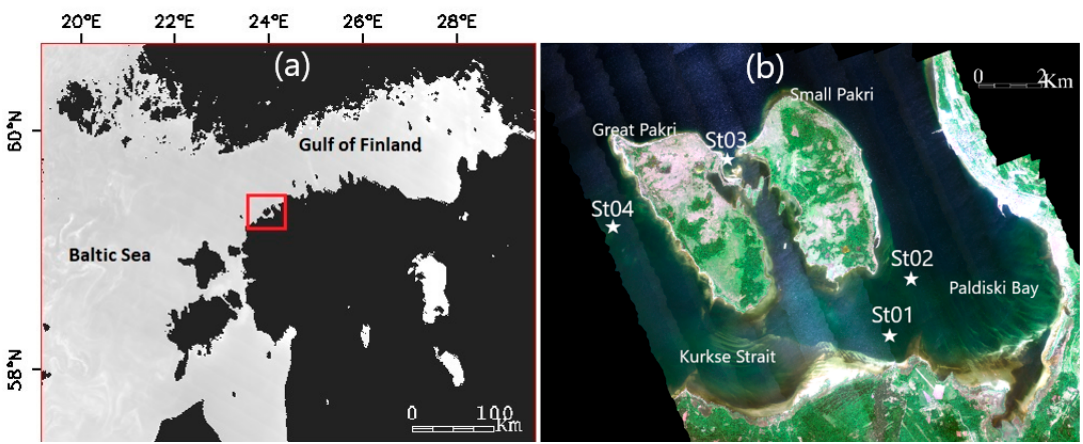
Figure 1. ( a ) Location of the study area in the northwestern coast of Estonia, in the Gulf of Finland within the Baltic Sea; ( b ) Compact Airborne Spectrographic Imager (CASI) mosaic from the study